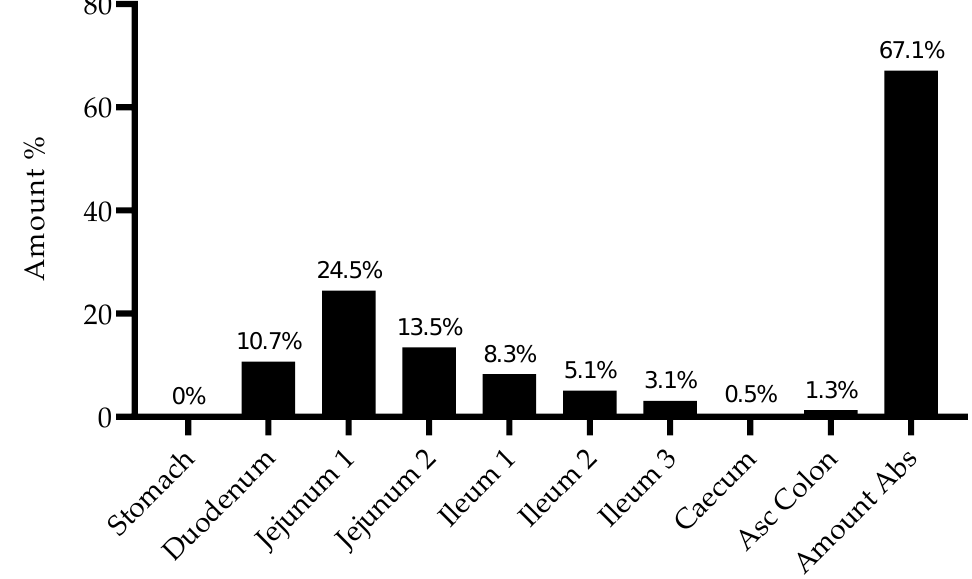
Figure 6. Simulated distribution of gemcitabine absorbed by different compartments after administration of a 1000 mg tablet three times a day.